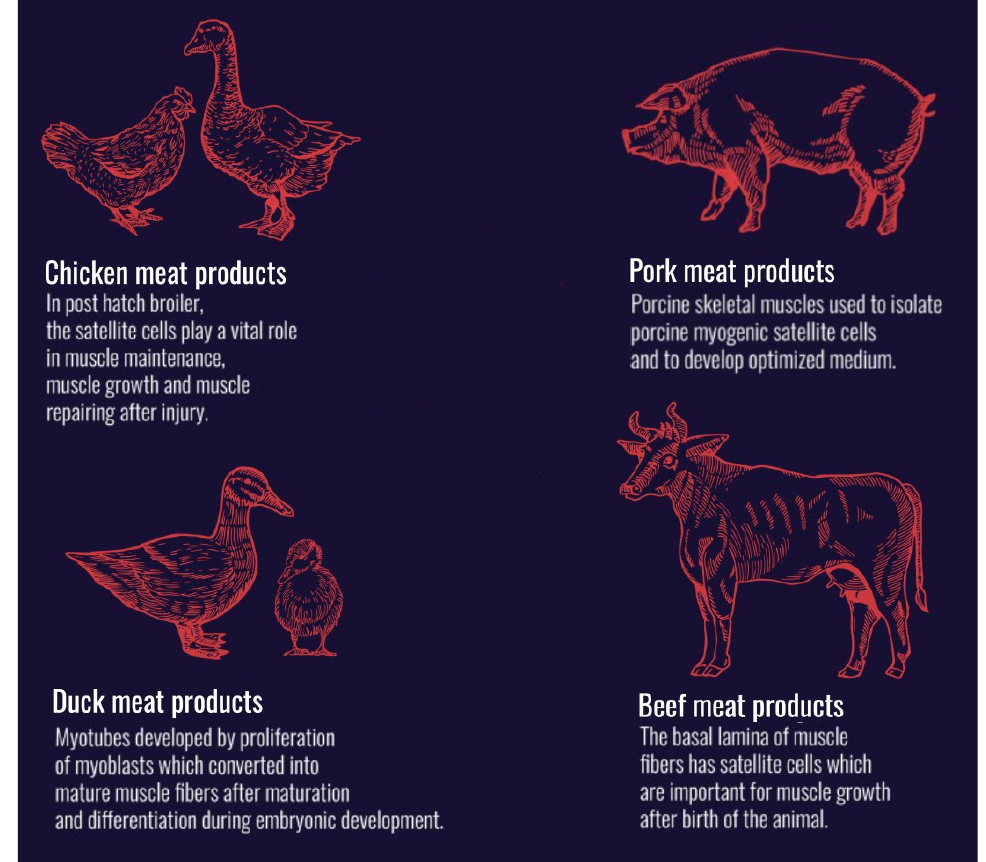
Figure 5. The main sources of cultured meat production.